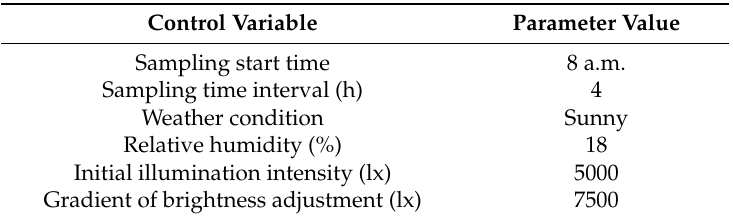
Table 8. Control variables for experiment on effect of illumination